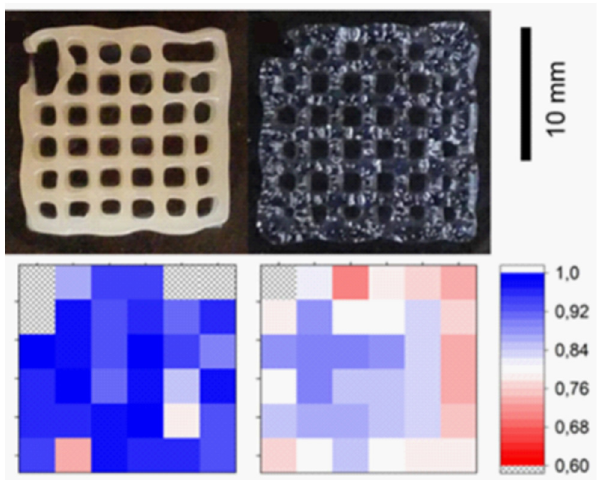
Figure 11. Shape fidelity of the printed PEGDA lattices using HT (left) and LAP (right) as rheological additives. The bottom row shows the shape fidelity of the comparison with the desired structure, graded with a color code. Blue shades depict a high accuracy or printing; Red indicates low confor- mity. Areas with printing errors are marked with “x”. Reproduced with permission from [81], Wiley Online Library,